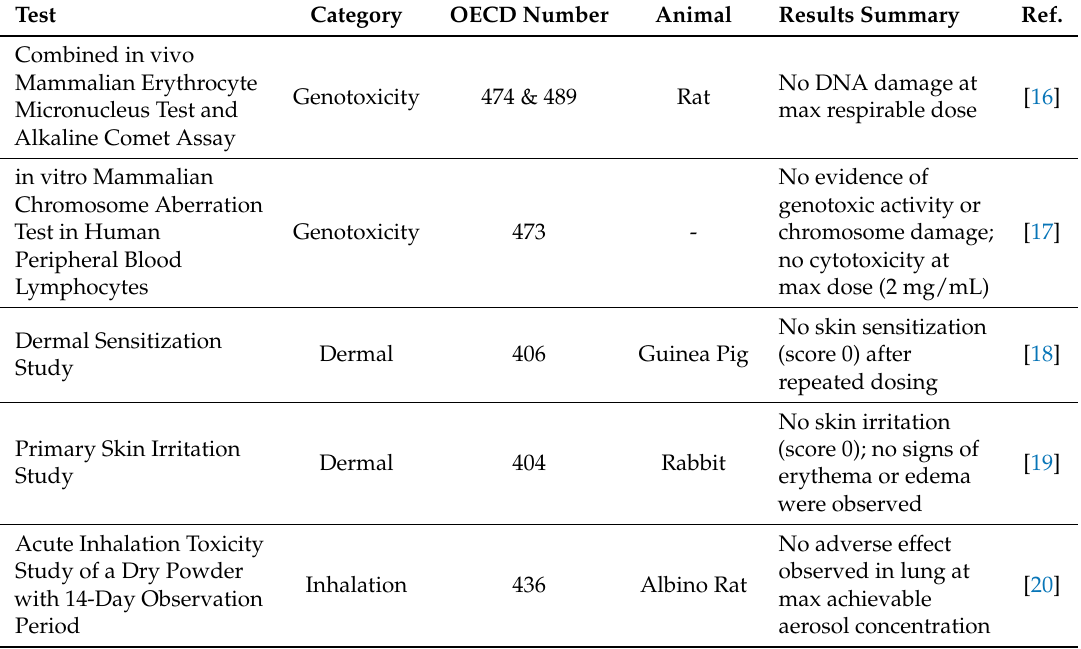
Table 1. List of toxicity tests on graphene cited in this